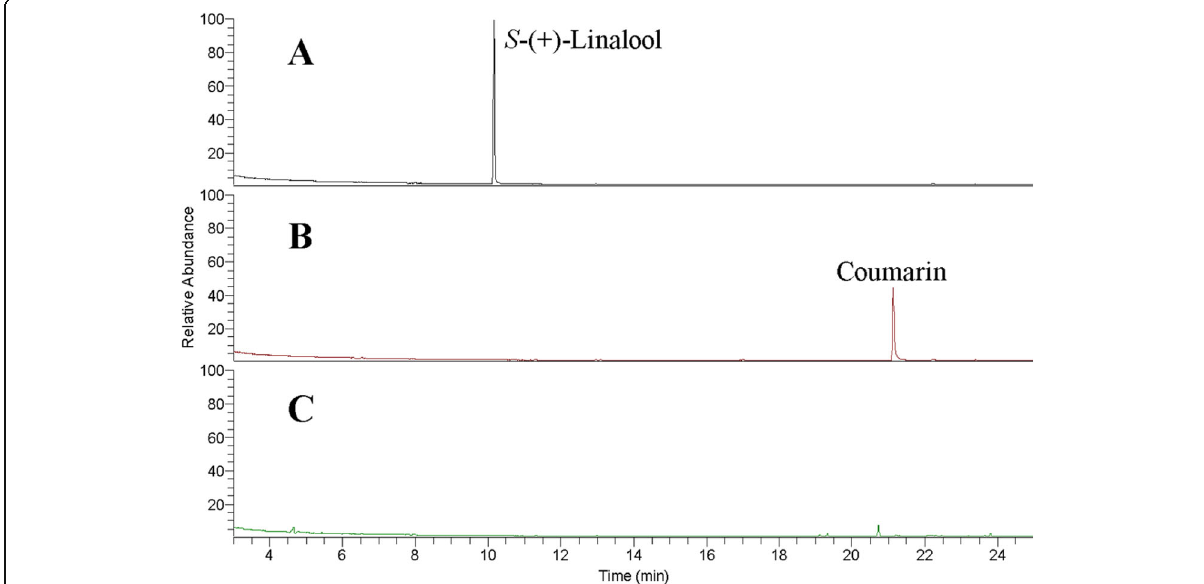
Fig. 3 Chromatogram of leaf extracts from Cinnamomum osmophloeum ct. linalool. a HD-EO. b n -Hexane soluble fraction separated from hot water extracts. c UAME-EO extracted from the leaf after HD extraction. HD: hydrodistillation. UAME: ultrasound-assisted